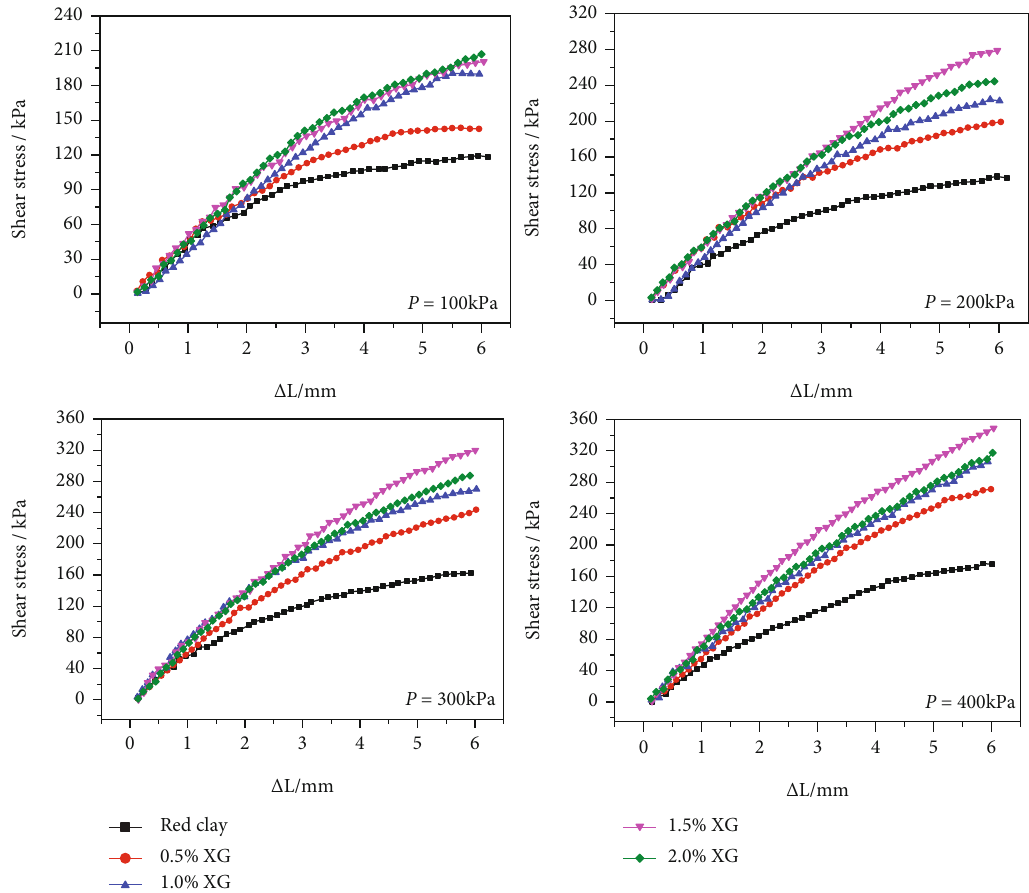
Figure 10: Shear stress and shear displacement of soil after curing for 28